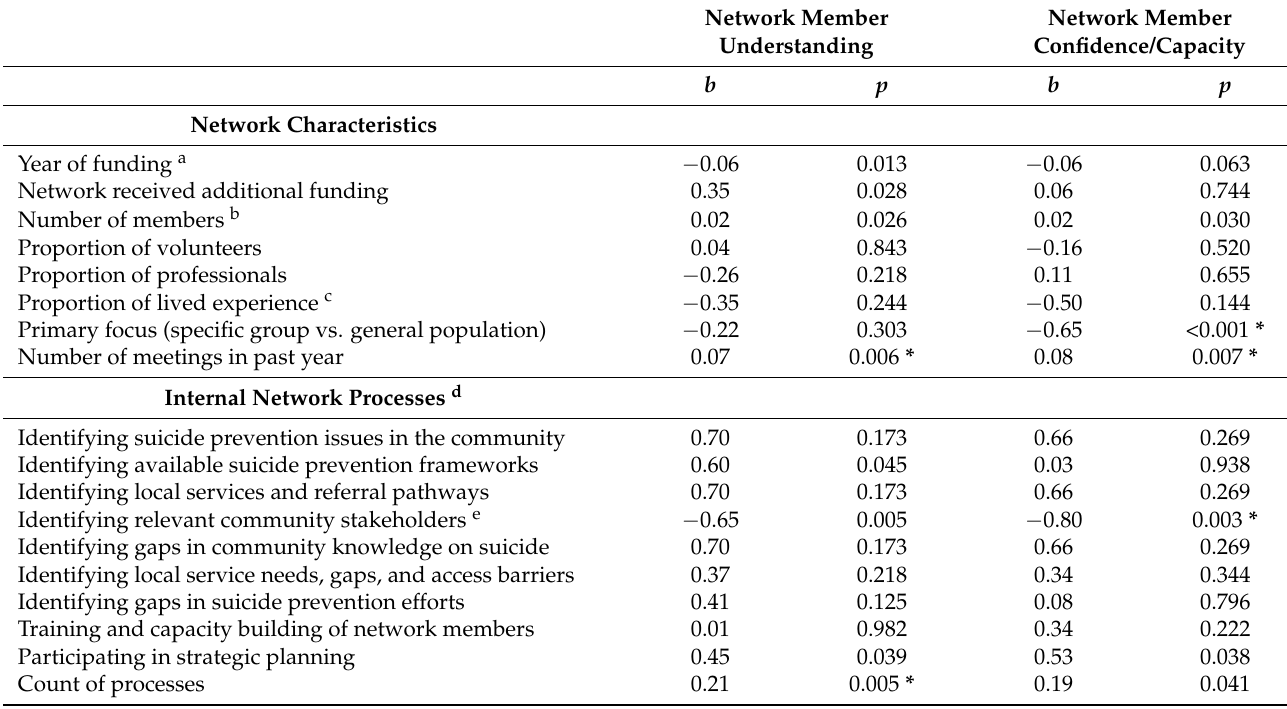
Table 5. Predictors of perceived network member outcomes (univariate linear